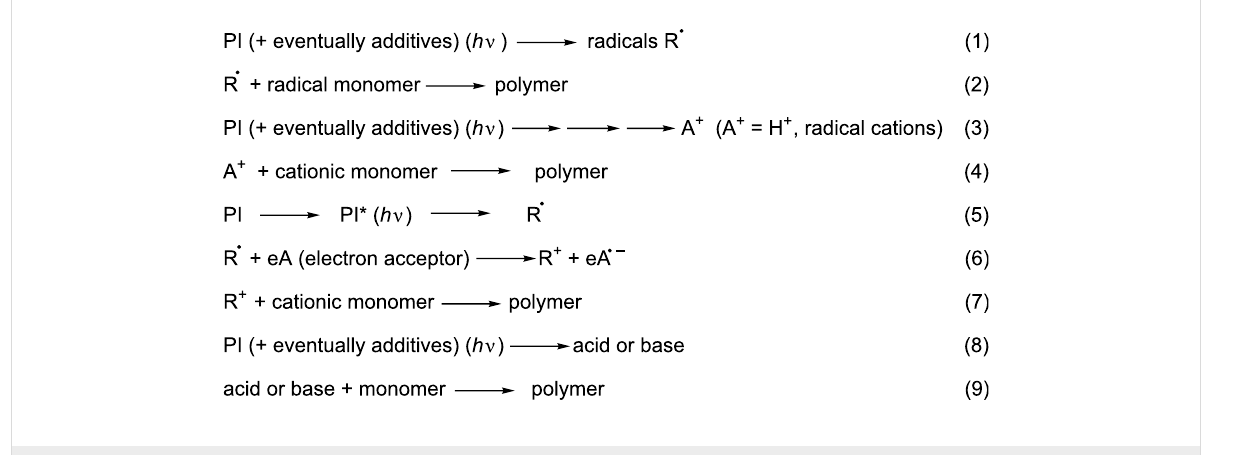
Scheme 1: Examples of photoinitiating